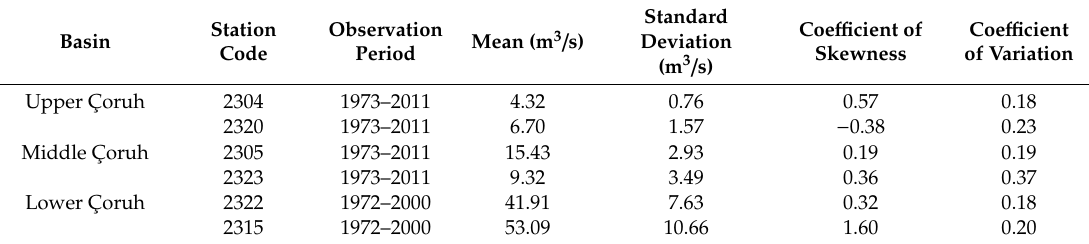
Table 1. Basic statistics of the gauge stations for 7-day low-flow series